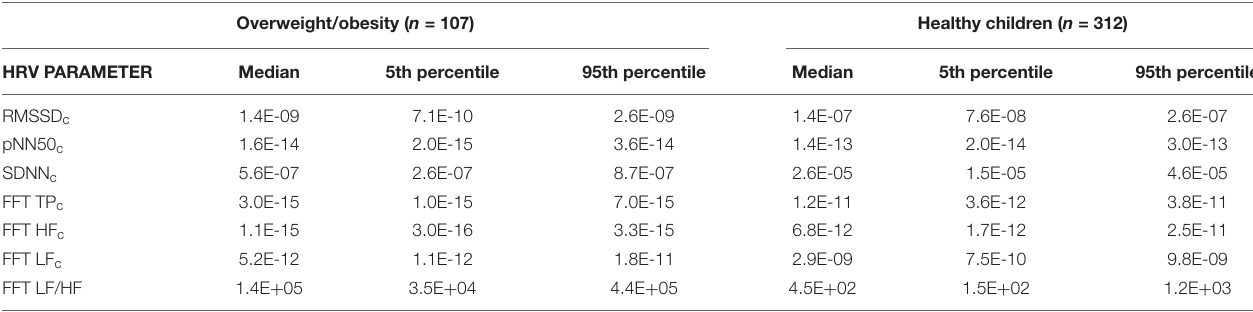
TABLE 2 | Normative values of corrected HRV parameters in children with overweight/obesity and values published previously in healthy weight children (Ga¸sior et al., 2018). Overweight/obesity ( n = 107) Healthy children ( n = 312)